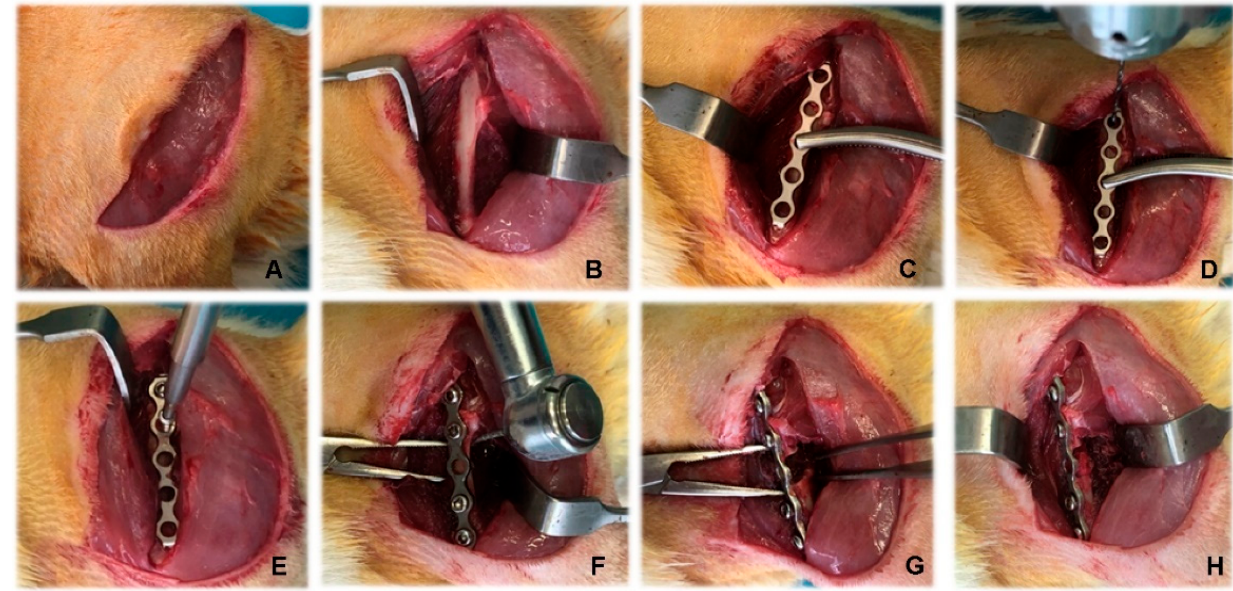
Figure 1. Stages of creation of rat femoral segmental critical-size defects. ( A ) Skin incision; ( B ) approach to the femoral shaft; ( C ) placement of plate; ( D ) drilling of holes for the screws; ( E ) placement of screws; ( F ) creation of the critical-size defect; ( G ) exposure of the defect; ( H ) placement of bio- materials.